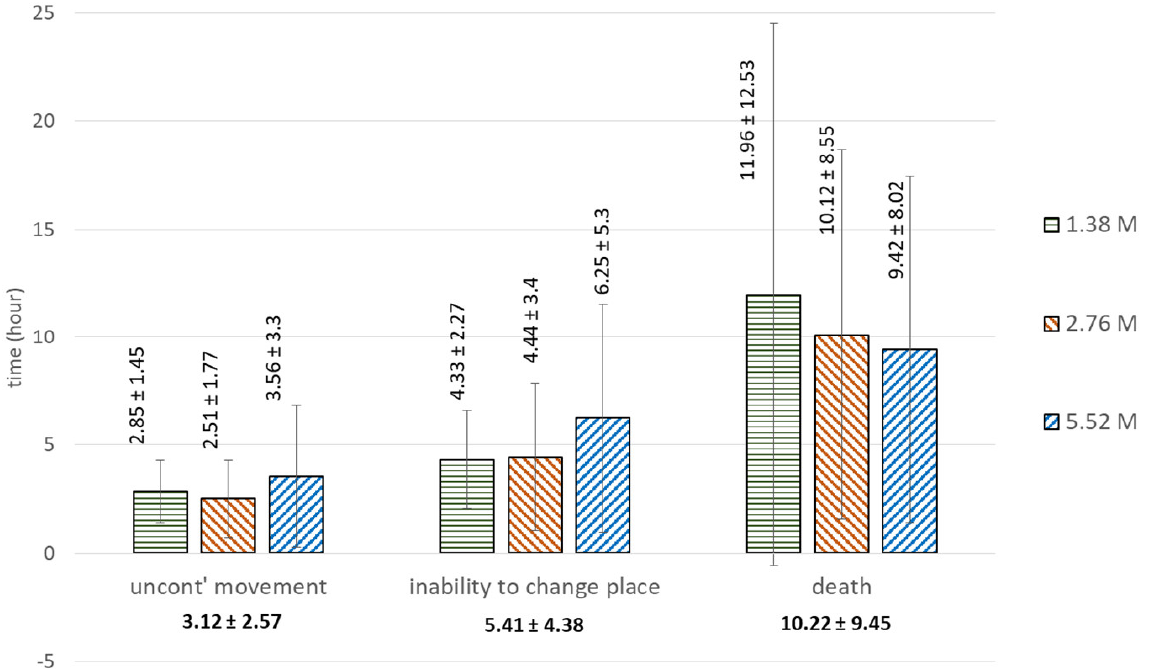
Figure 1. Mean time ± SD (hours) from immersion to the mortality stages in Test I, by lithium chloride concentration (note: treatment concentrations had no significant effect on the exposure time to reach any of the mortality stages). Table 2. Mean ± SD for exposure times (hours) by lithium chloride concentrations in Test I. Concentration